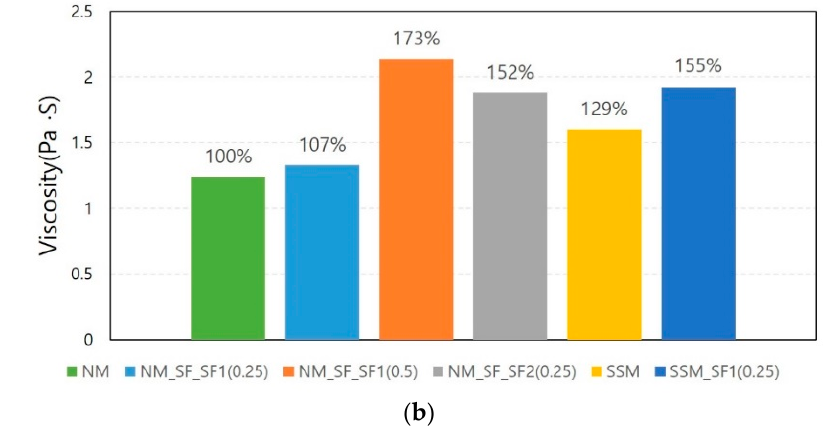
Figure 7. Average yield stress and viscosity measured without magnetic field: ( a ) yield stress, ( b ) viscosity .